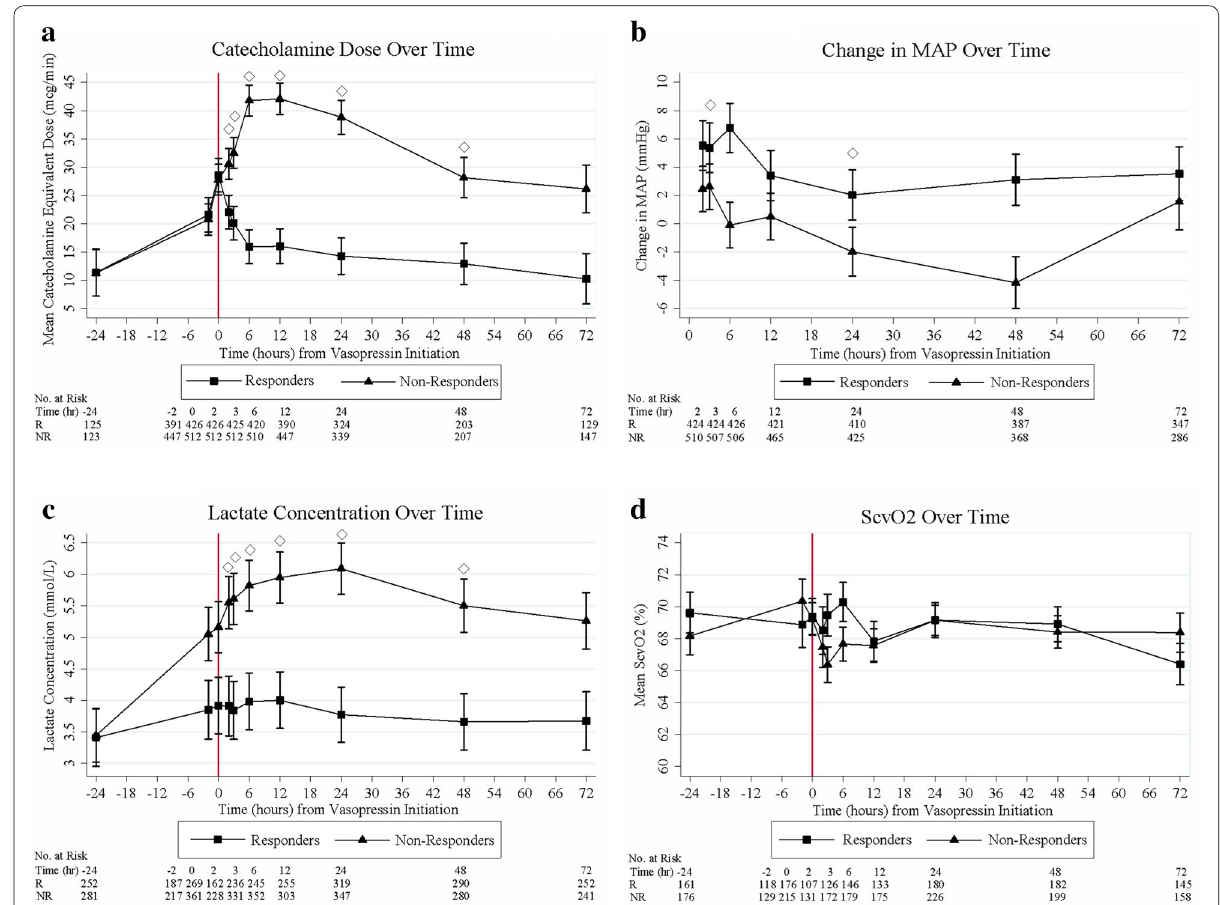
Fig. 2 Patient results over time for vasopressin responders and non-responders. a Catecholamine dose from -24 h to 72 h after vasopressin initia- tion. Responders had significantly lower catecholamine doses at 2, 3, 6, 12, 24 and 48 h after vasopressin initiation compared to non-responders. b Change in MAP from time 0 to 72 h after vasopressin initiation. Responders had significantly higher degrees of MAP change at 3 and 24 h after vasopressin initiation compared to non-responders. c Changes in lactate concentration from -24 h to 72 h after vasopressin initiation. Responders had significantly lower lactate concentrations at 2, 3, 6, 12, 24, and 48 h compared to nonresponders. d ScvO 2 from -24 h to 72 h after vasopressin initiation. There was no difference in ScvO 2 between responders and non-responders at any time point evaluated. MAP mean arterial pressure; NR non-responders; R responders; ScvO2 central venous oxygen saturation. Data are means, with error bars indicating standard deviation. ◊ P <